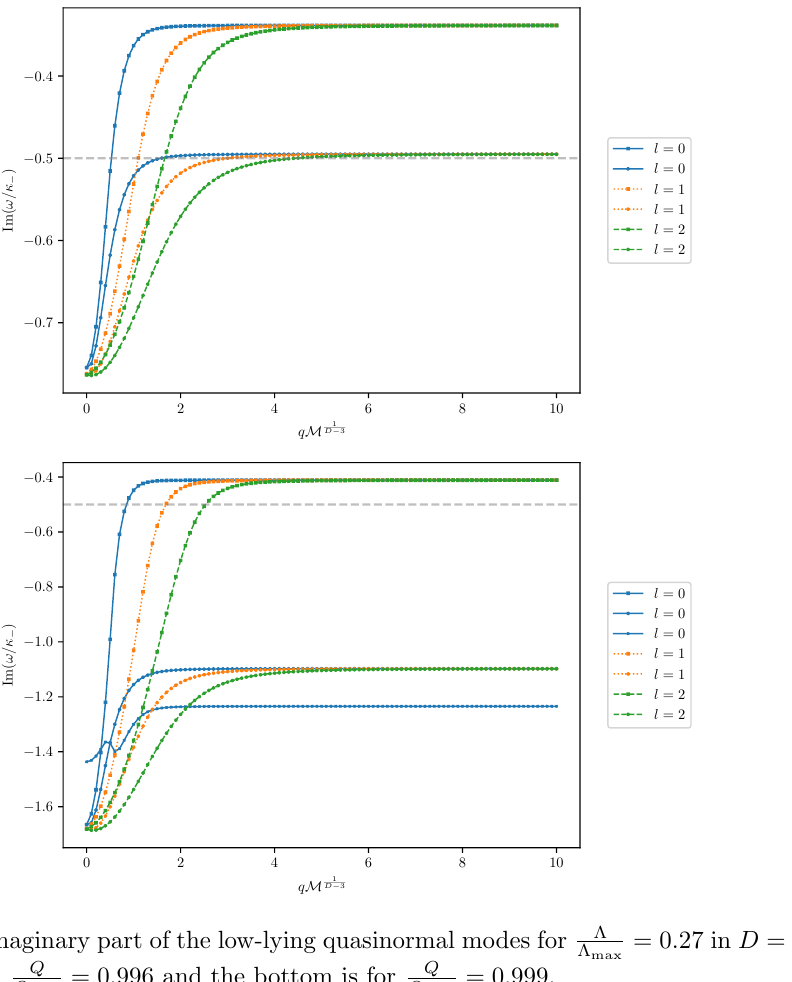
= 0 : 27 in D = 4, where (cid:3) max = 0 : 999. Q max